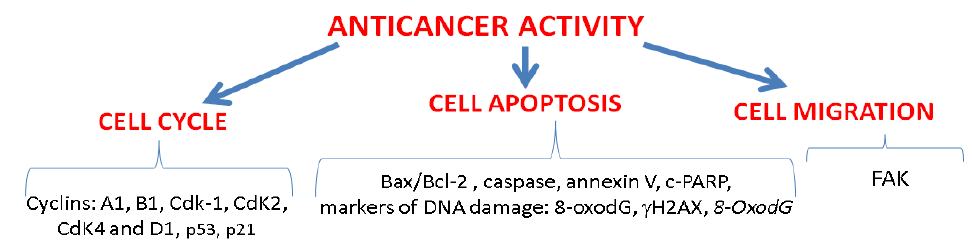
Figure 3. Main molecular mechanisms and the investigated parameters associated with anticancer activity studied in carnivorous plants from Nepenthales.